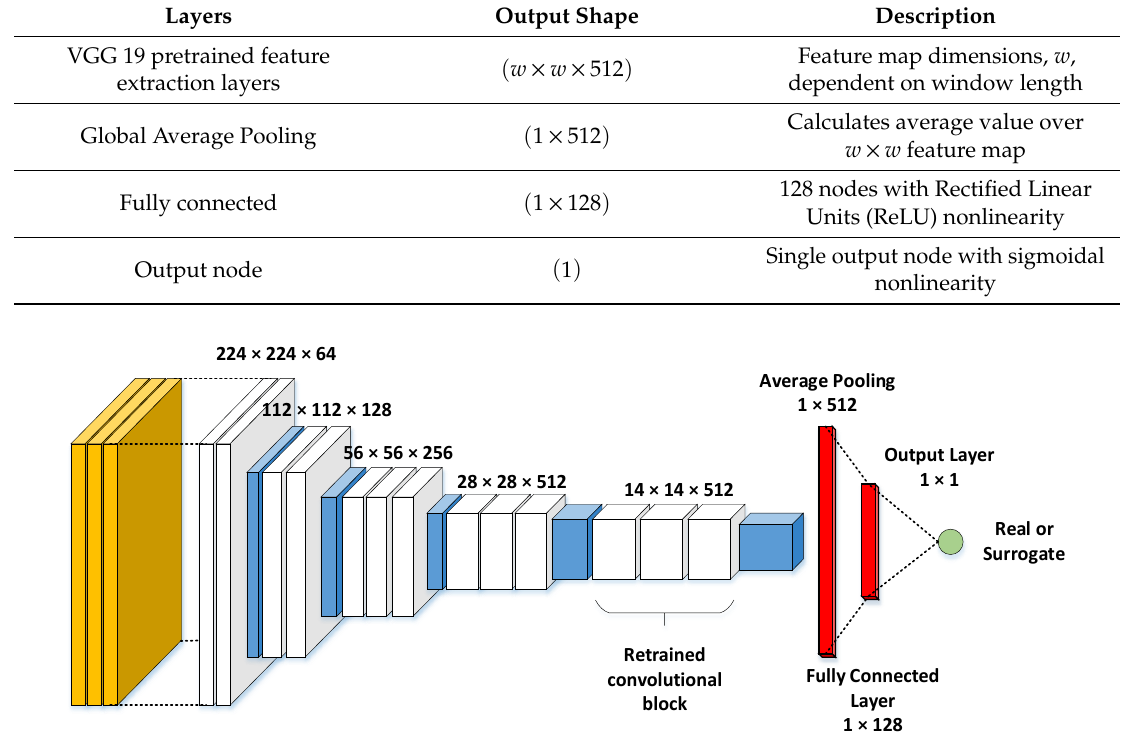
Figure 7. VGG19 CNN modified for contrast-based learning.